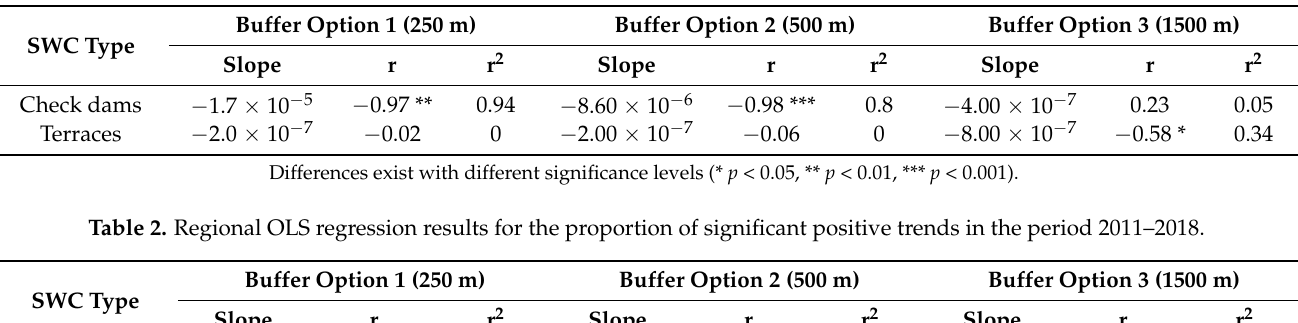
Table 1. Regional OLS regression results for median trend differences (all trends).